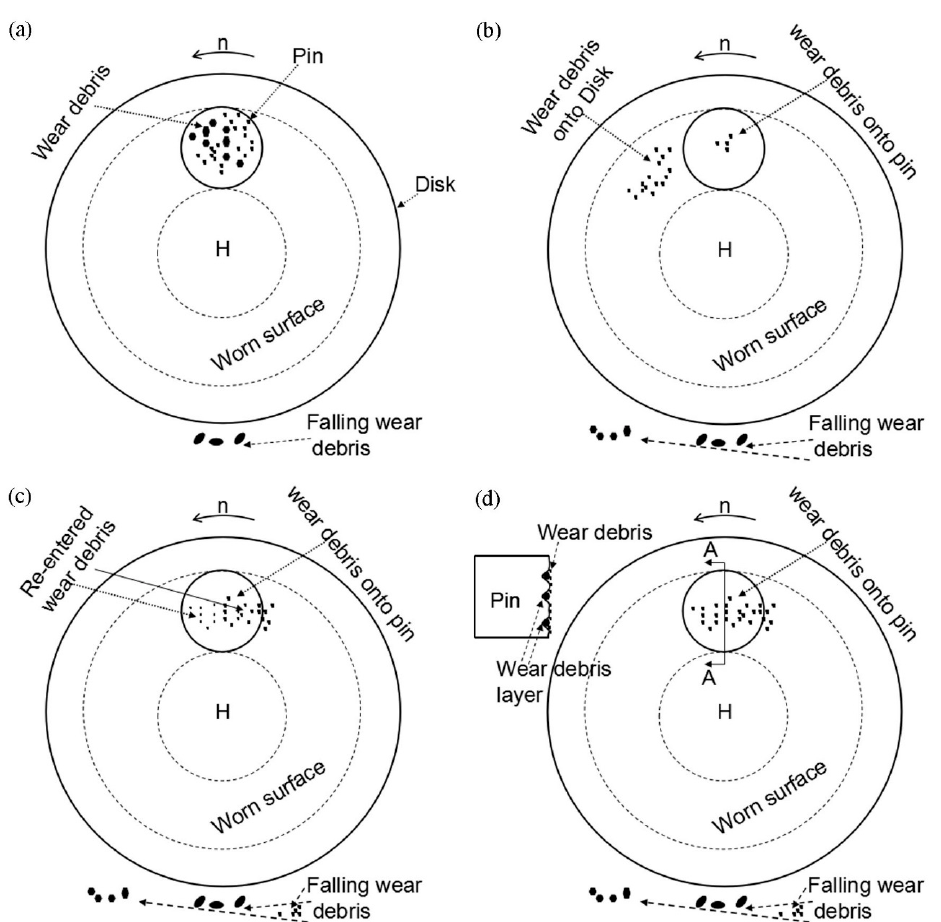
( b ) movement accompanying the disk; ( c ) grinding; and, ( d )